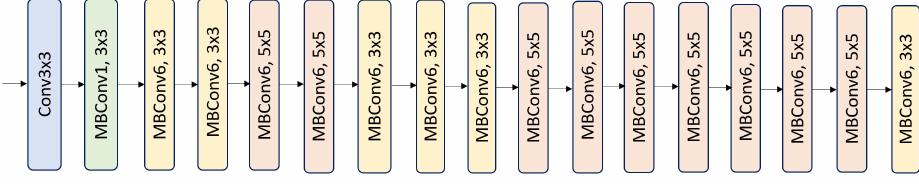
Figure 7. EfficientNet model